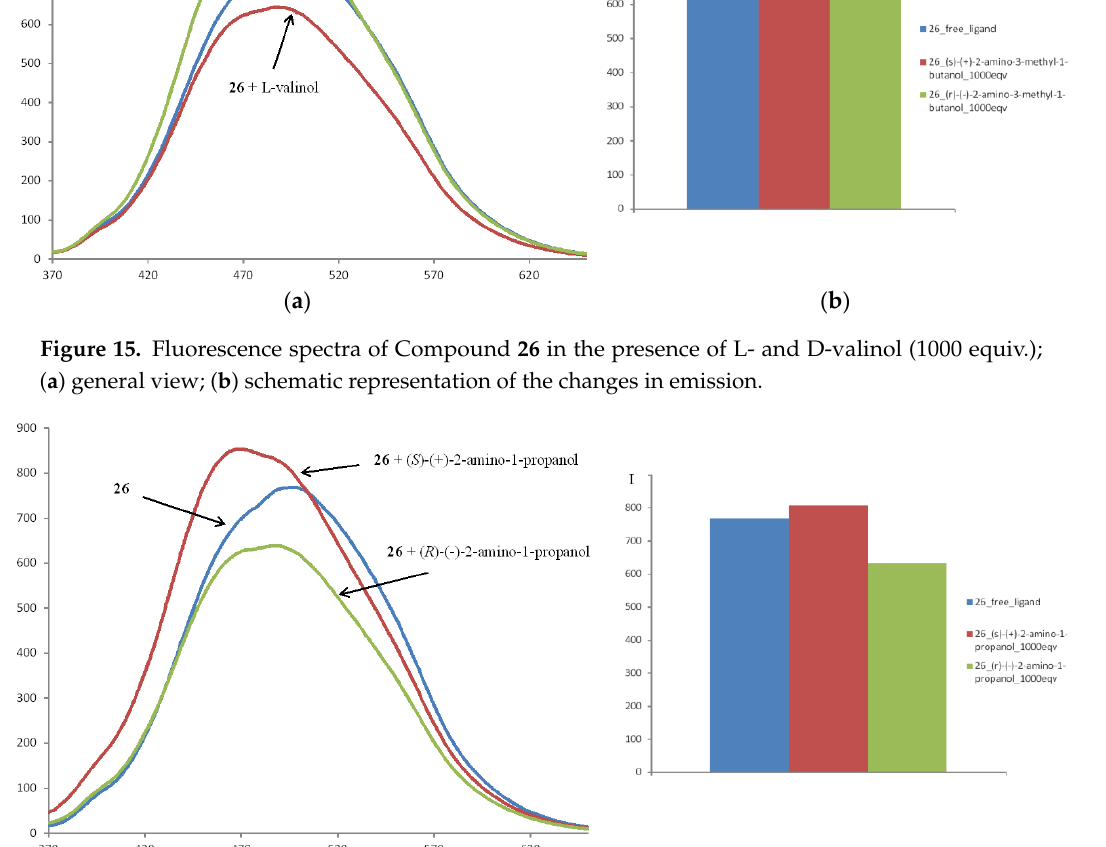
Figure 15. Fluorescence spectra of compound 26 in the presence of L- and D-valinol (1000 equiv.); (a) general view ; (b) schematic representation of the changes in emission.